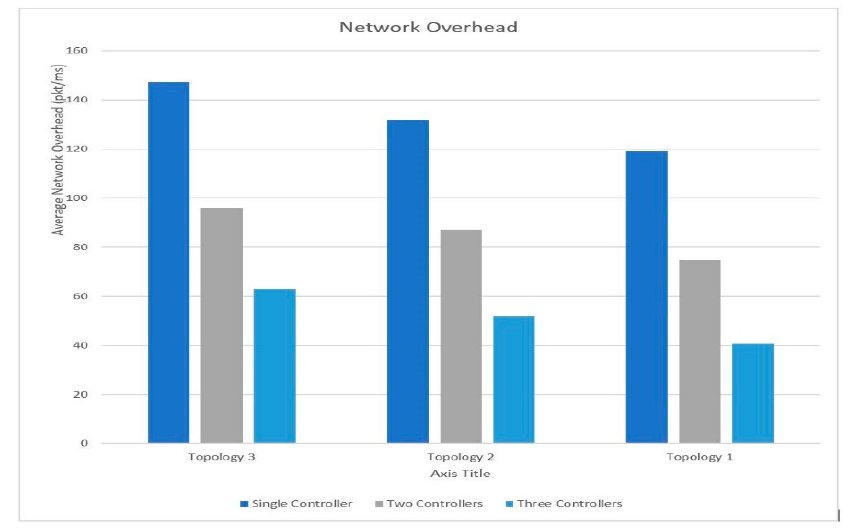
Figure 10. Network